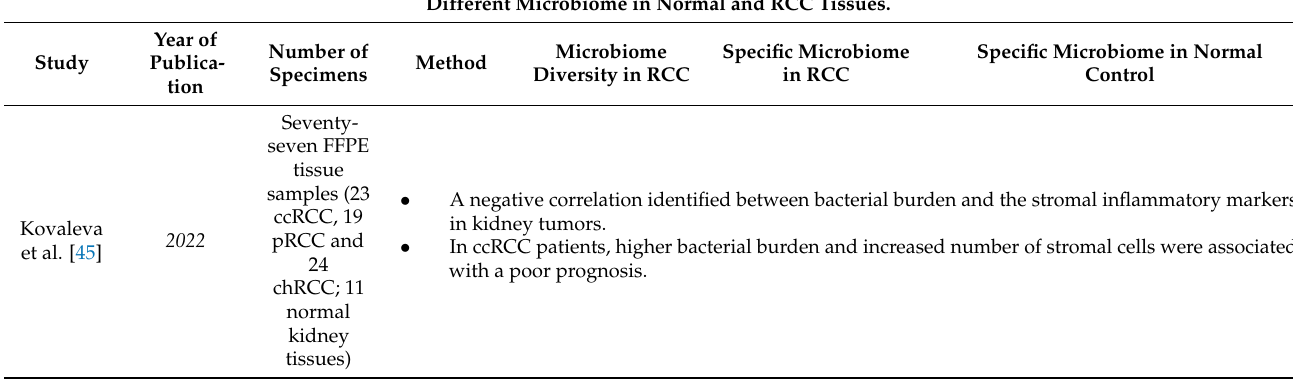
Table 1. Cont. Different Microbiome in Normal and RCC